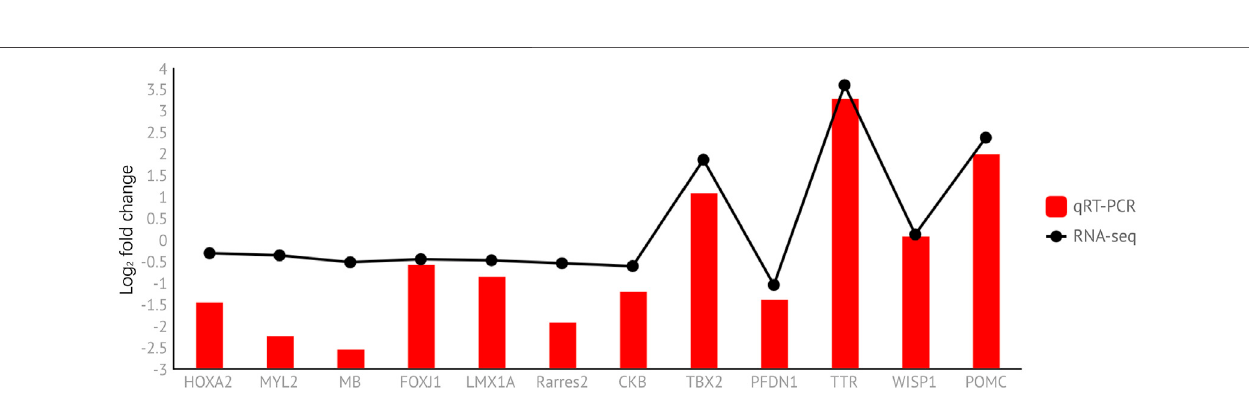
FIGURE 10 | Expression level of DEGs was veri fi ed using qRT-PCR and compared with the corresponding data from RNA-Seq assays. The y -axis indicates normalized expression levels of the transcripts. The x -axis indicates differentially expressed genes.